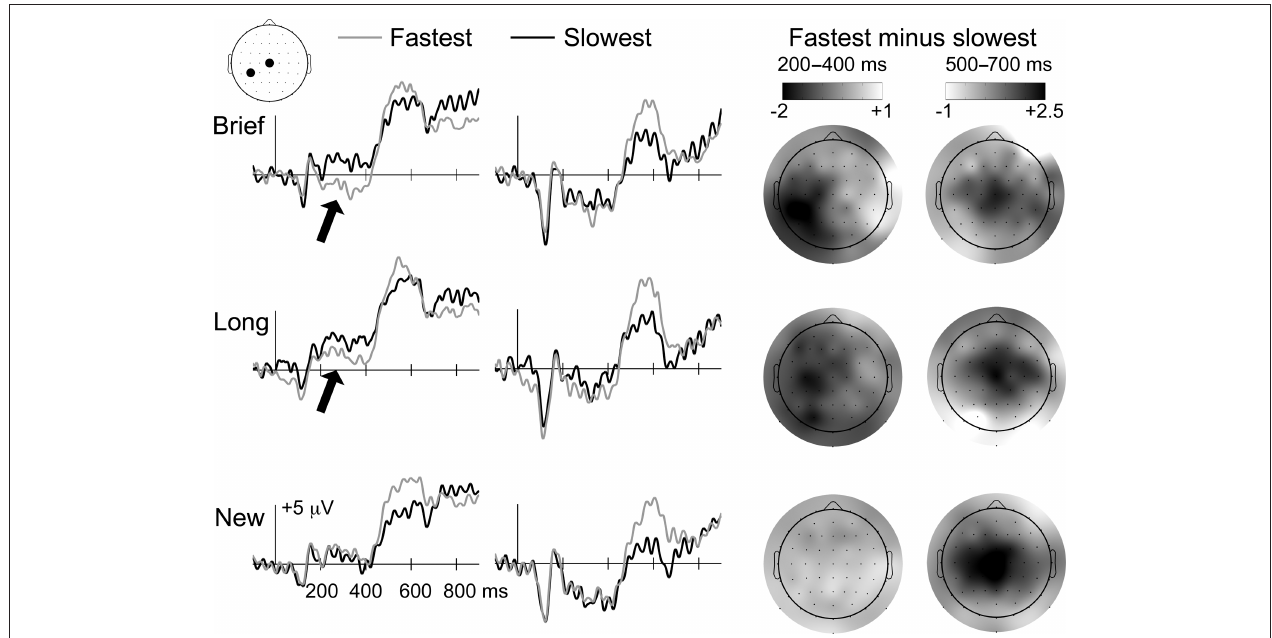
and greater positive differences for 500–700 ms, as indicated by the color bars. Arrows are used to highlight portions of the ERP waveforms that were attributed to priming, which was selective for Brief and Long objects. This selectivity is also apparent in the topographic maps for the 200–400 ms interval, which show negative left occipitotemporal effects for Brief and Long objects only. In contrast, the later-onset positive effect was identified for all three object types, and therefore did not reflect repetition-induced memory influences on